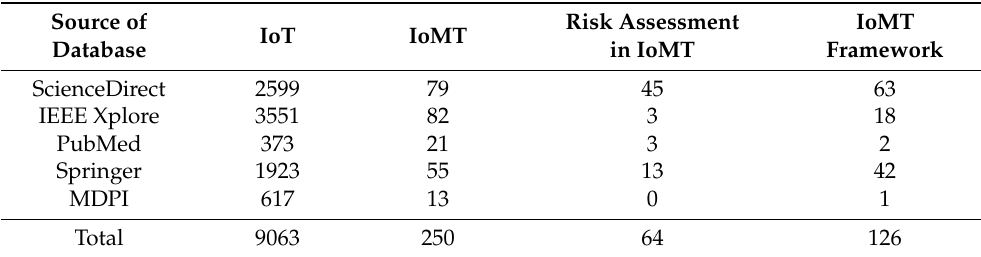
Table 2. Keyword search of all indexing